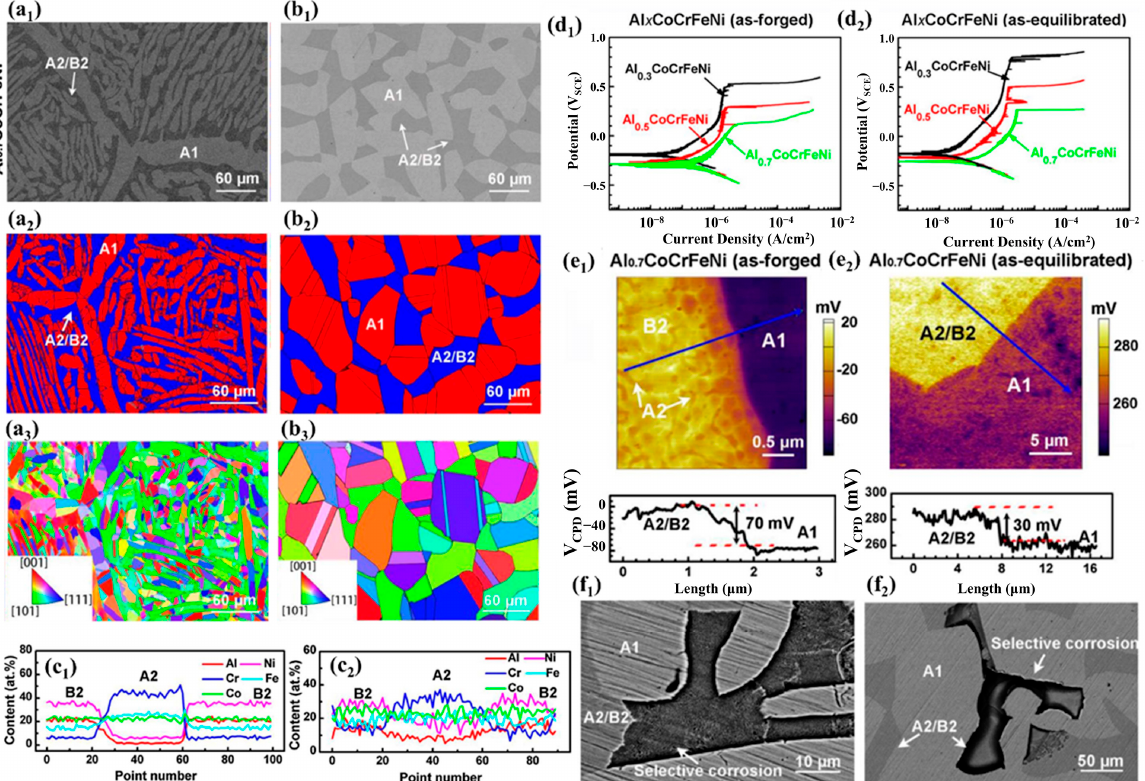
Figure 9. The effect of homogenization on the microstructure characterizations, electrochemical polarizations, and surface corroded morphologies for Al 0.7 CoCrFeNi HEAs. The surface morphology images, phase maps, and inverse pole-figures (IPF) of ( a 1 – a 3 ) the as-forged and ( b 1 – b 3 ) the as-equilibrated Al 0.7 CoCrFeNi, the red areas are A1 phases while the blue areas are A2/B2 phases in ( a 2 , b 2 ), the different colours in ( a 3 , b 3 ) represent the grains with different oriented; the elemental distribution line-scanning by TEM-EDS of ( c 1 ) the as-forged and ( c 2 ) the as-equilibrated Al 0.7 CoCrFeNi, the different colours of the lines represent different elements; potentiodynamic polarization plots of ( d 1 ) the as-forged and ( d 2 ) as-equilibrated Al 0.7 CoCrFeNi in 3.5 wt.% NaCl solution, in which the black curve is Al 0.3 CoCrFeNi, the red curve is Al 0.5 CoCrFeNi, the green curve is Al 0.7 CoCrFeNi; ( e 1 ) the contact potential difference (V CPD ) map and line scanning of the as-forged Al 0.7 CoCrFeNi, the net-like A2 precipitates with a lower V CPD distributed inside the bright B2 matrix; ( e 2 ) V CPD maps and line profiles for the as-equilibrated Al 0.7 CoCrFeNi at the phase boundary, the blue arrows are the line scanning sites, the bright areas are the phases with high V CPD , and vice versa, the red dotted lines represent the average values of different phases; surface morphologies of ( f 1 ) the as-forged and ( f 2 ) the as-equilibrated Al 0.7 CoCrFeNi after the potentiodynamic polarization tests, the white arrows represent the selective corrosion of phases. [17].